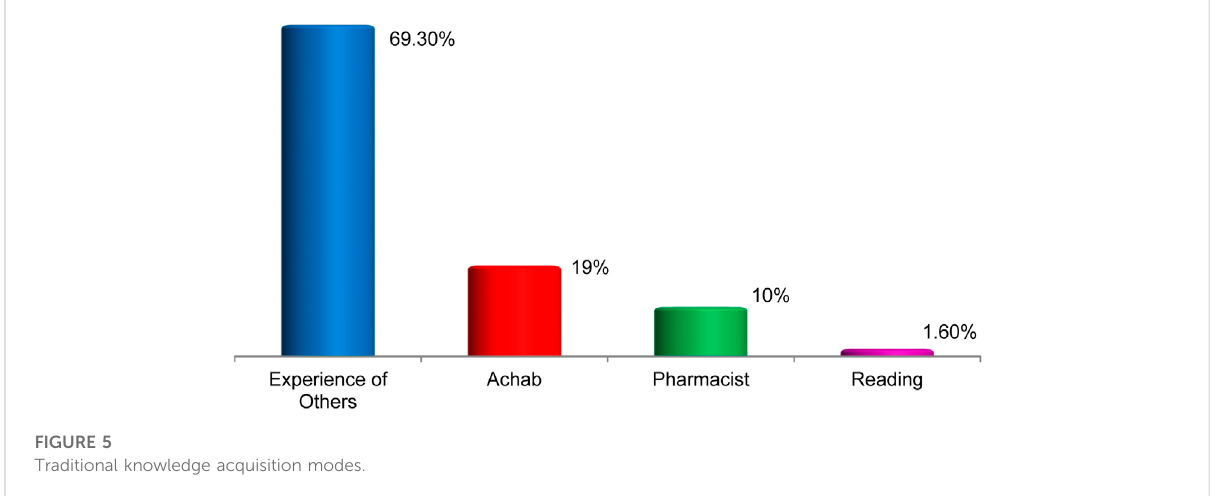
FIGURE 5 Traditional knowledge acquisition modes.